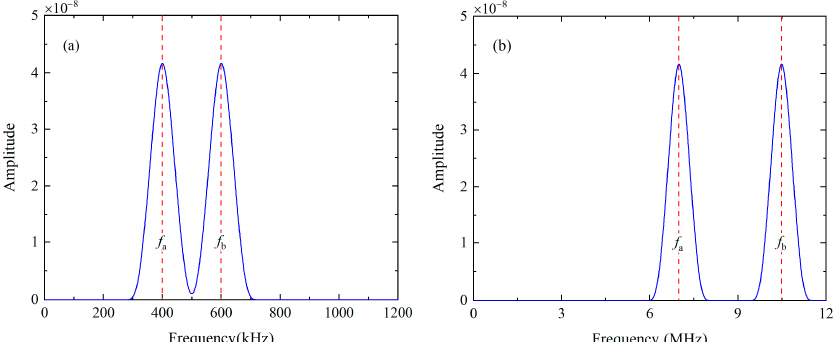
Figure 3. Frequency spectra of the excitation signals in the first ( a ) and second ( b ) mode triplet.